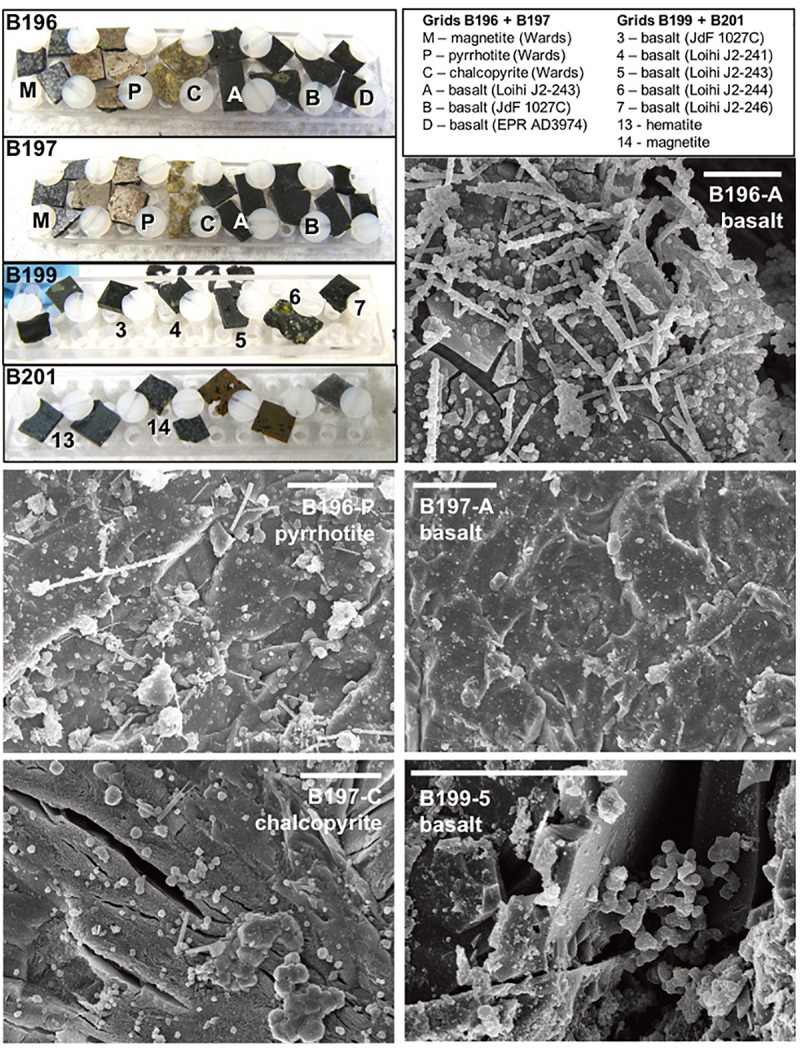
Select scanning electron micrographs (SEM) from rock chips incubated downhole at Hole U1362B (see Supplementary Figures S3–S6 for additional images). The upper left panel shows photographs of the rock chips before deployment on IODP Exp. 327, with grid labels and rock chip types indicated in the legend. Basalt chips were created from field samples collected previously from the East Pacific Rise (EPR, a glassy basalt collected on Alvin dive 3974), from Juan de Fuca Ridge flank (JdF, from ODP Hole 1027C), and from the Loihi Seamount (two highly vesicular aphyric basalts from ROV Jason dives J2-241 and J2-243, and two olivine-phyric basalt from dives J2-244 and J2-246). The metal sulfides chips were prepared from commercially available samples from Wards Geology. Representative scanning electron microscopy (SEM) micrographs from three basalt samples and two metal sulfides are shown; scale bars in each are 10 μm.